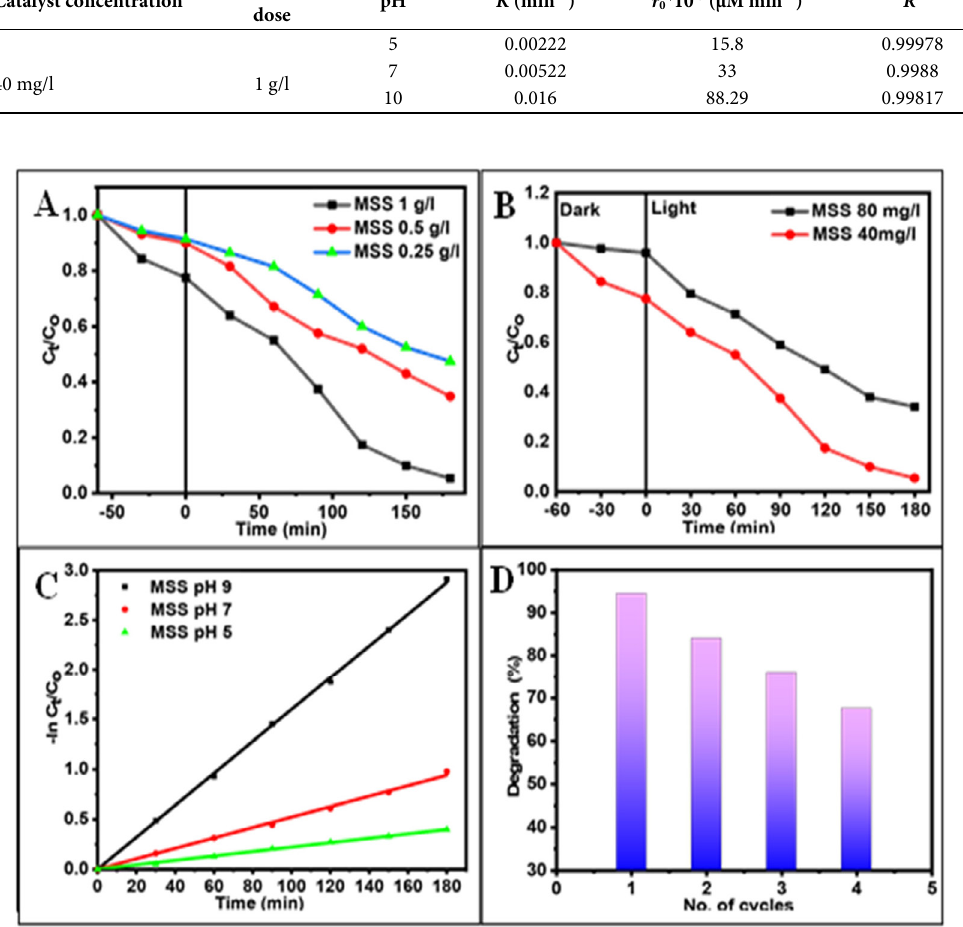
Fig. 10. the effect of sample dose [A], dye concentration [B], linear relation [C] and recyclable experiment [D] on the photocatalytic activity of MSS sample.